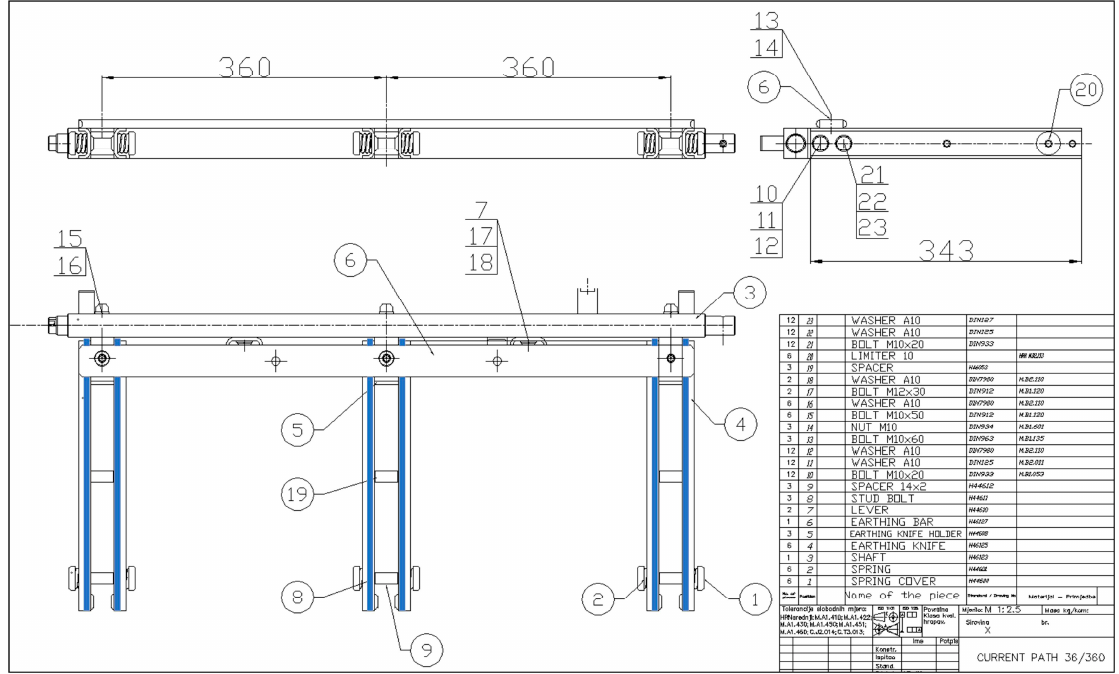
Figure 1. Medium-voltage (MV) earthing switch type RGB 38-25 detail drawings; for the purpose of comparison the blue color is showing the alternative design (copper knifer without braces).